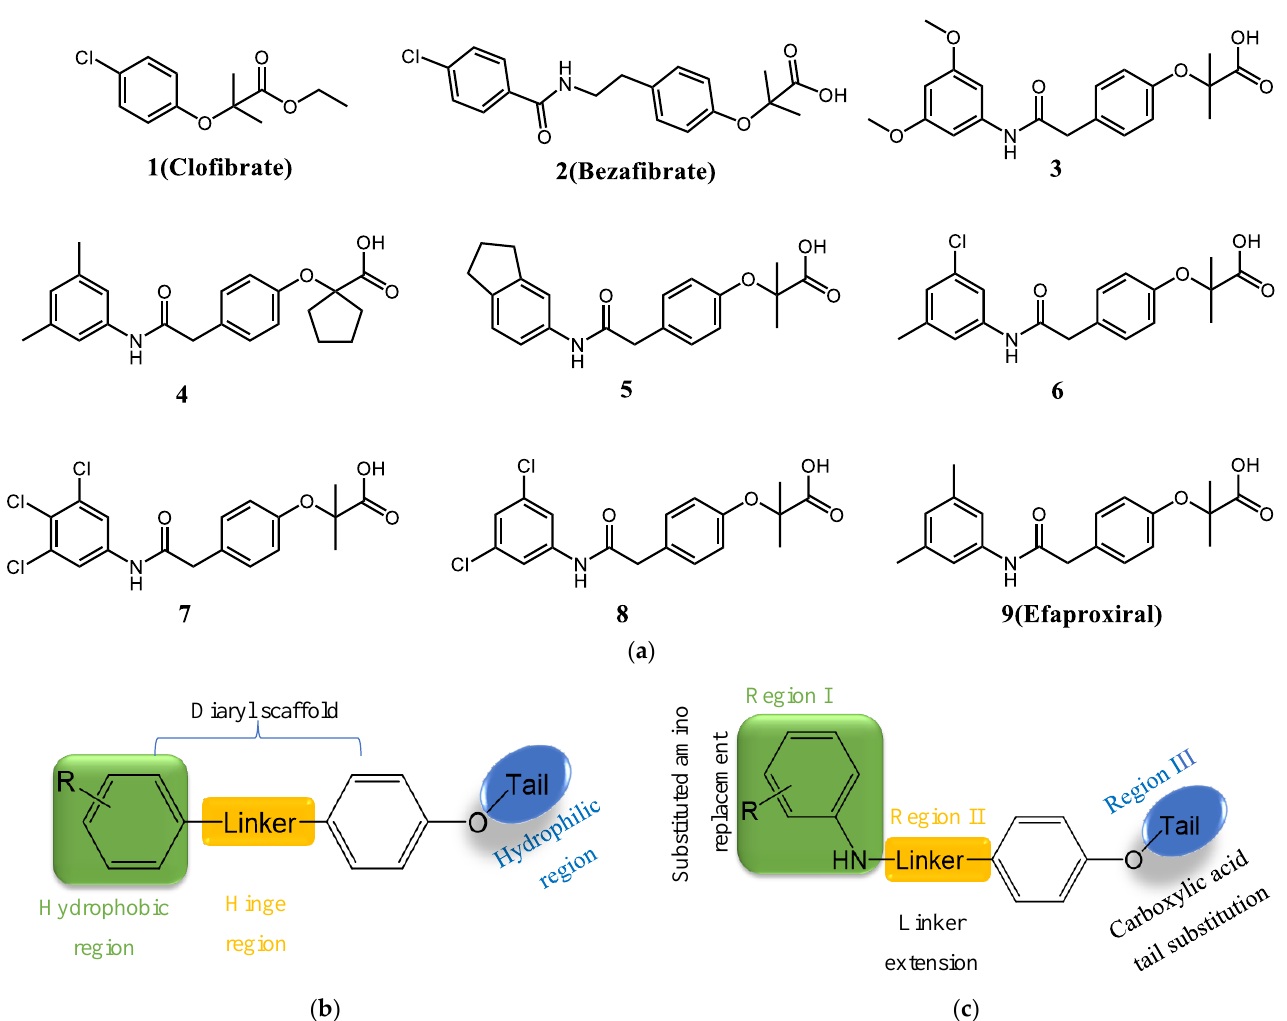
Figure 1. Compound design strategies. ( a ) Chemical structures of reported hemoglobin allosteric effectors. ( b ) Common features of phenoxyaromatic acids analogues. ( c ) Design of target compound.